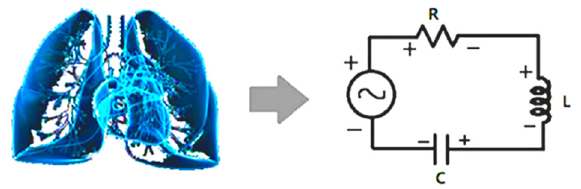
Figure 2. Schematic diagram of cardiopulmonary system and its circuit model. Interaction between lung and heart resembles the energy flow between inductor and capacitor. The non-respiration factors are equivalent to resistor, damping the resonance.